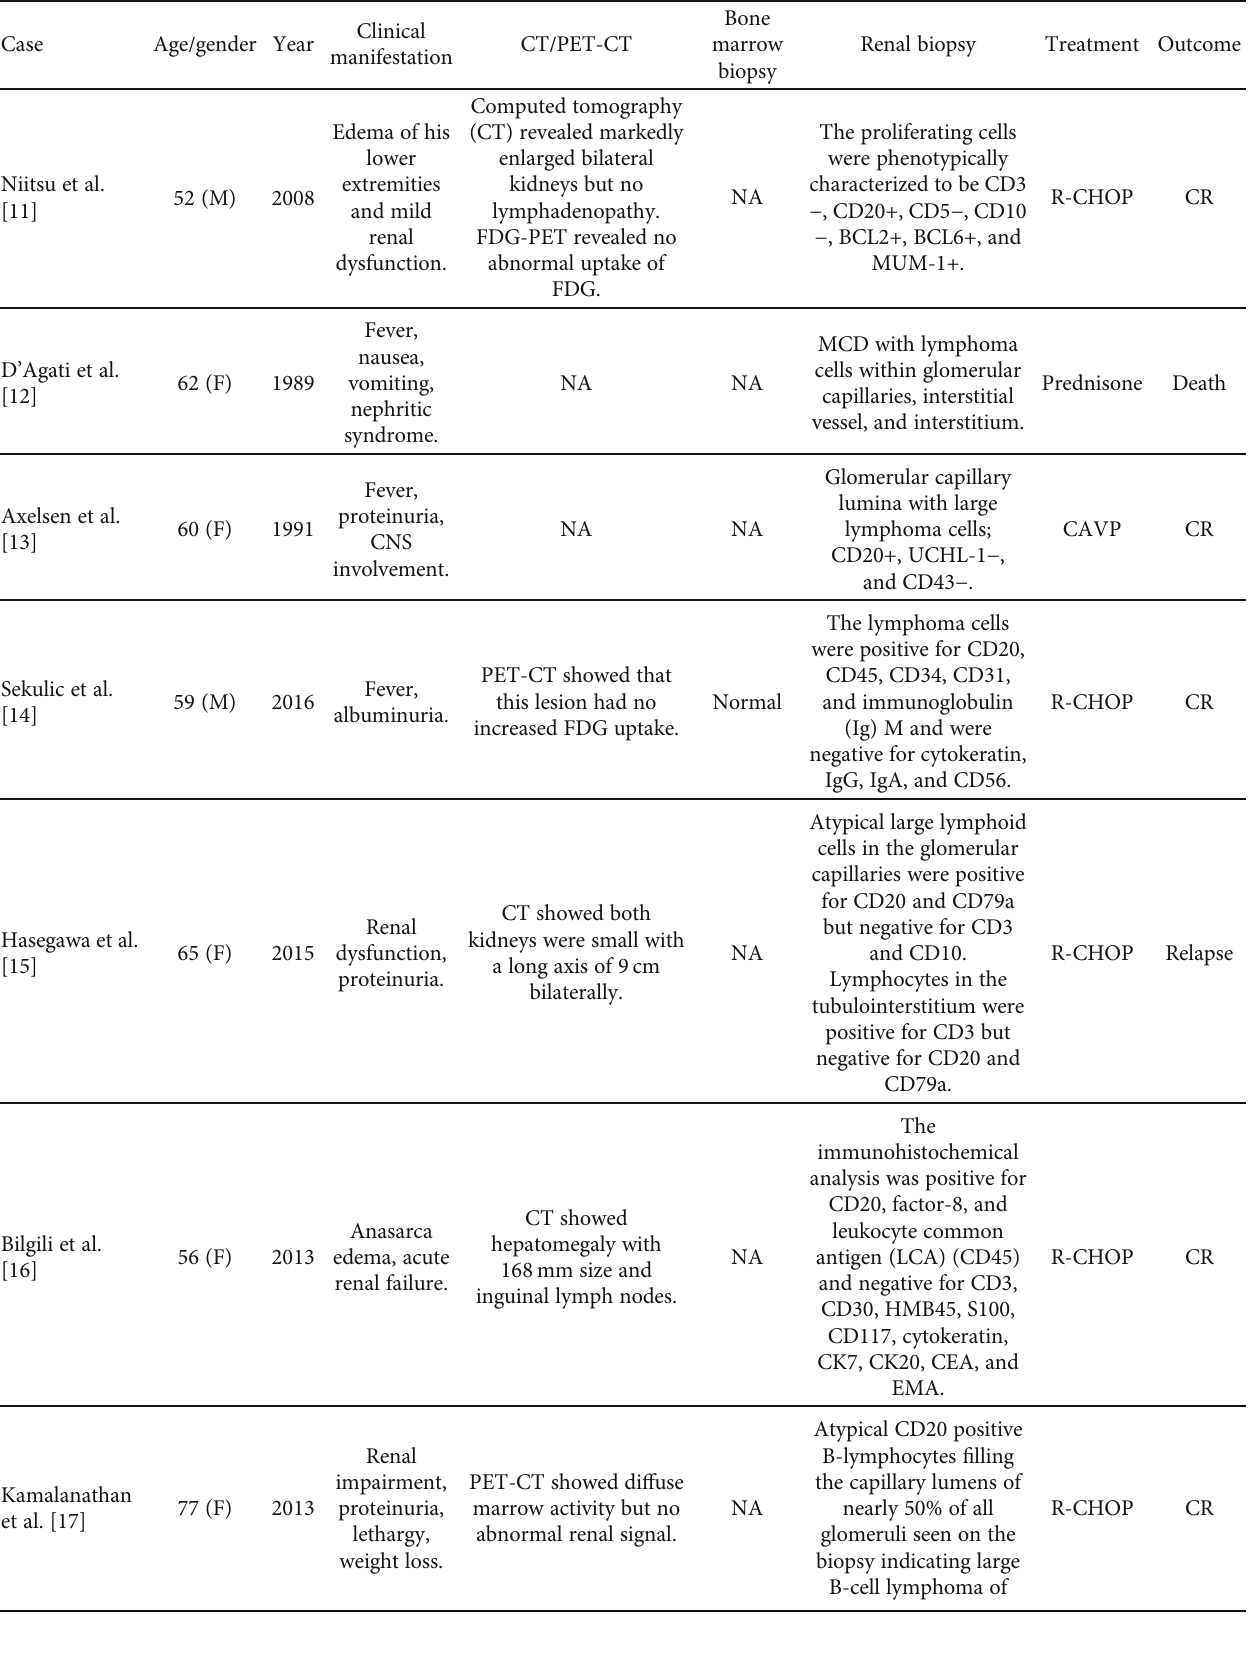
Table 1: Patients with intravascular large B-cell